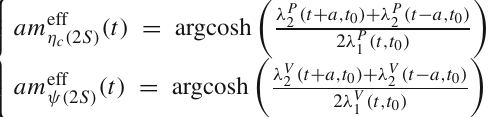
(left panel) and m J /ψ (right panel) by linear expressions in m 2 π and a 2